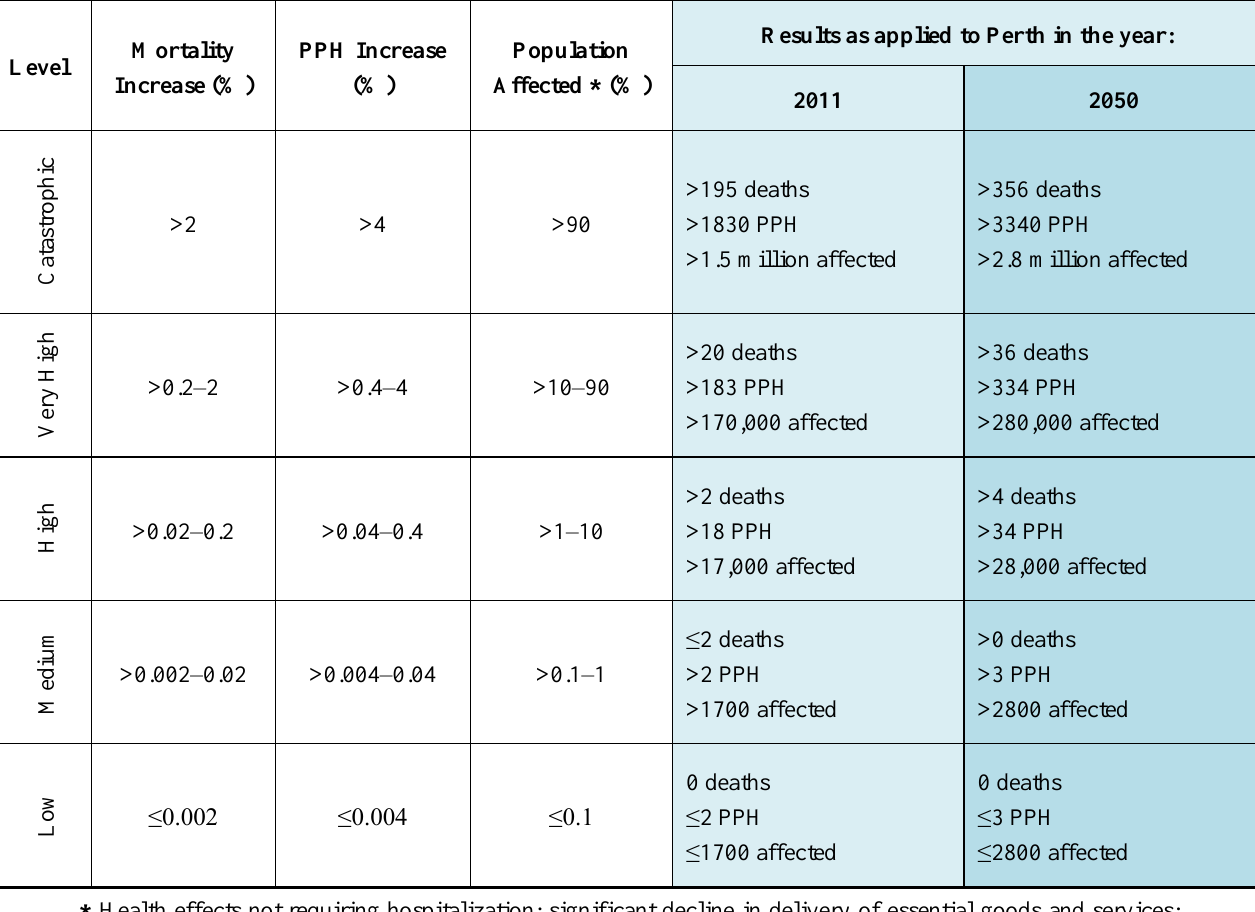
Table 1. Health consequence scales applied to Perth in 2011 and